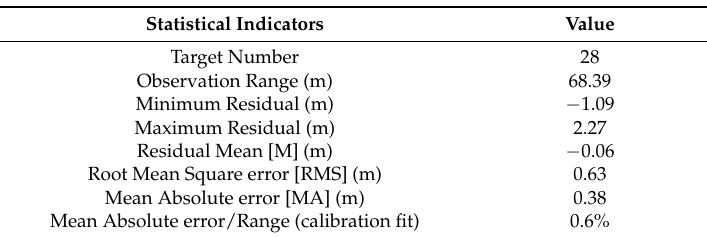
Table 1. General statistics resulting from the model.